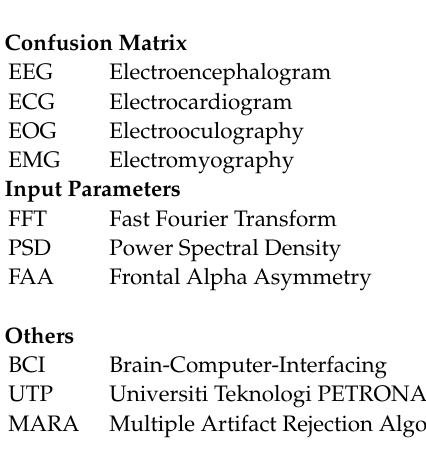
Figure S3: Example of DBSCAN clustering results for mean delta power at the following electrode: (a) channel F3, (b) channel F4 and (c) combination of channel F3 & F4, Figure S4: Example of DBSCAN clustering results for mean alpha power at the following electrode: (a) channel F3, (b) channel F4 and (c) combination of channel F3 & F4, Figure S5: Example of k-means clustering results for